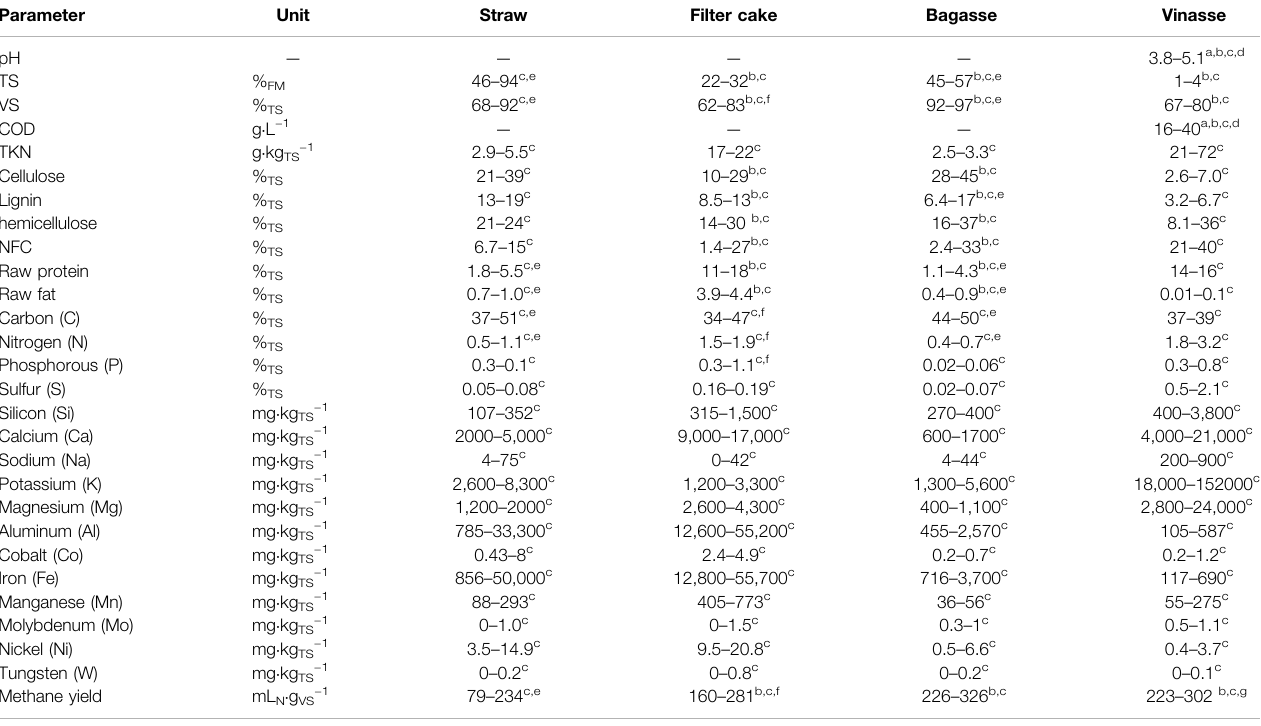
TABLE 1 | Composition and major characteristics of the wastes produced by the sugarcane industry. Parameter